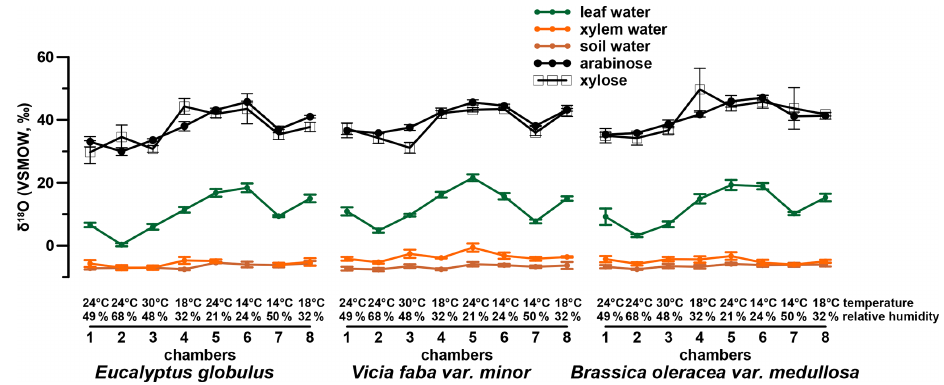
Figure 3. δ 18 O values of plant water (leaf water, xylem water and soil water) isotope compositions (in green, orange and brown, respectively) and the isotope composition of the investigated hemicellulose-derived sugars: arabinose and xylose as dots and open squares, respectively.